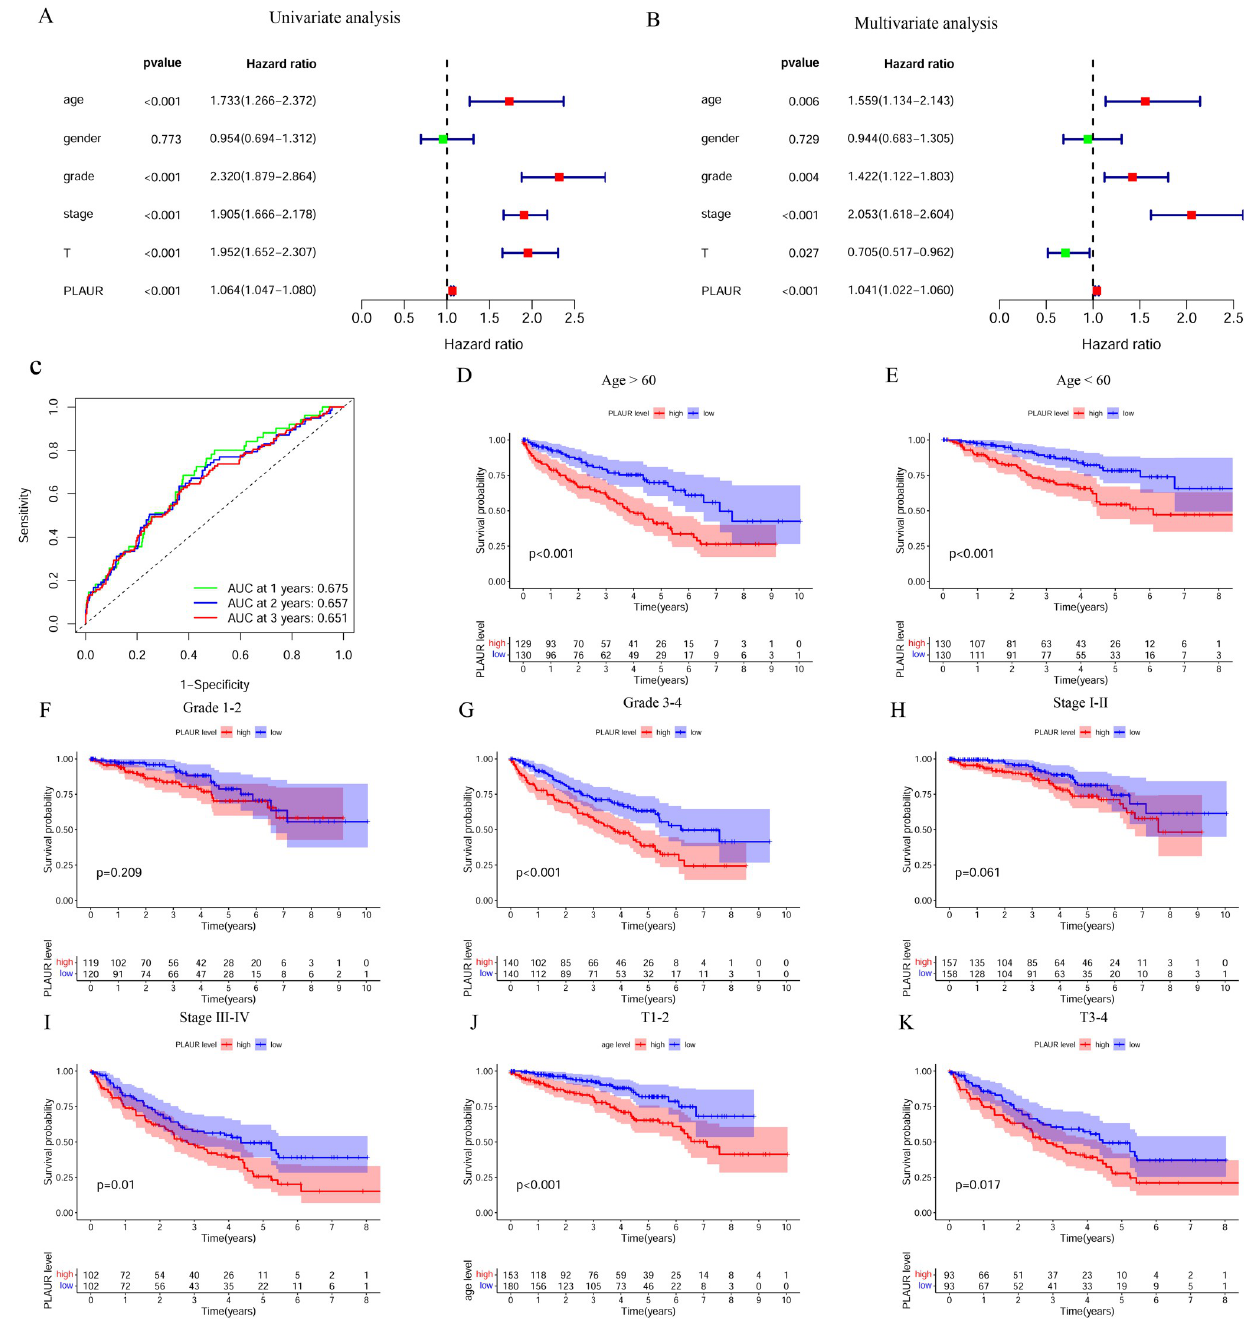
Fig 4. Univariate and multivariate Cox regression analysis and stratified analysis of PLAUR in ccRCC. A. Univariate Cox regression analysis; B. Multivariate Cox regression analysis; C. Prognostic efficacy of PLAUR for ccRCC. D-K. Stratified